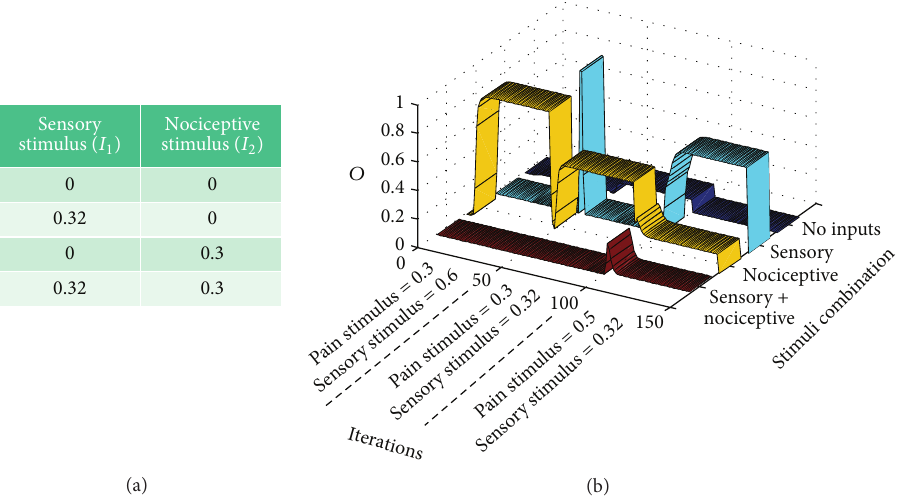
Figure 8: Modeling demyelinating syndromes: after 50 iterations with standard training epochs, signals from sensory receptors are weakened like in a demyelinating syndrome. Abnormal pain sensations only take place from iteration 100 with pain sensations when a sensory signal is input to the gate